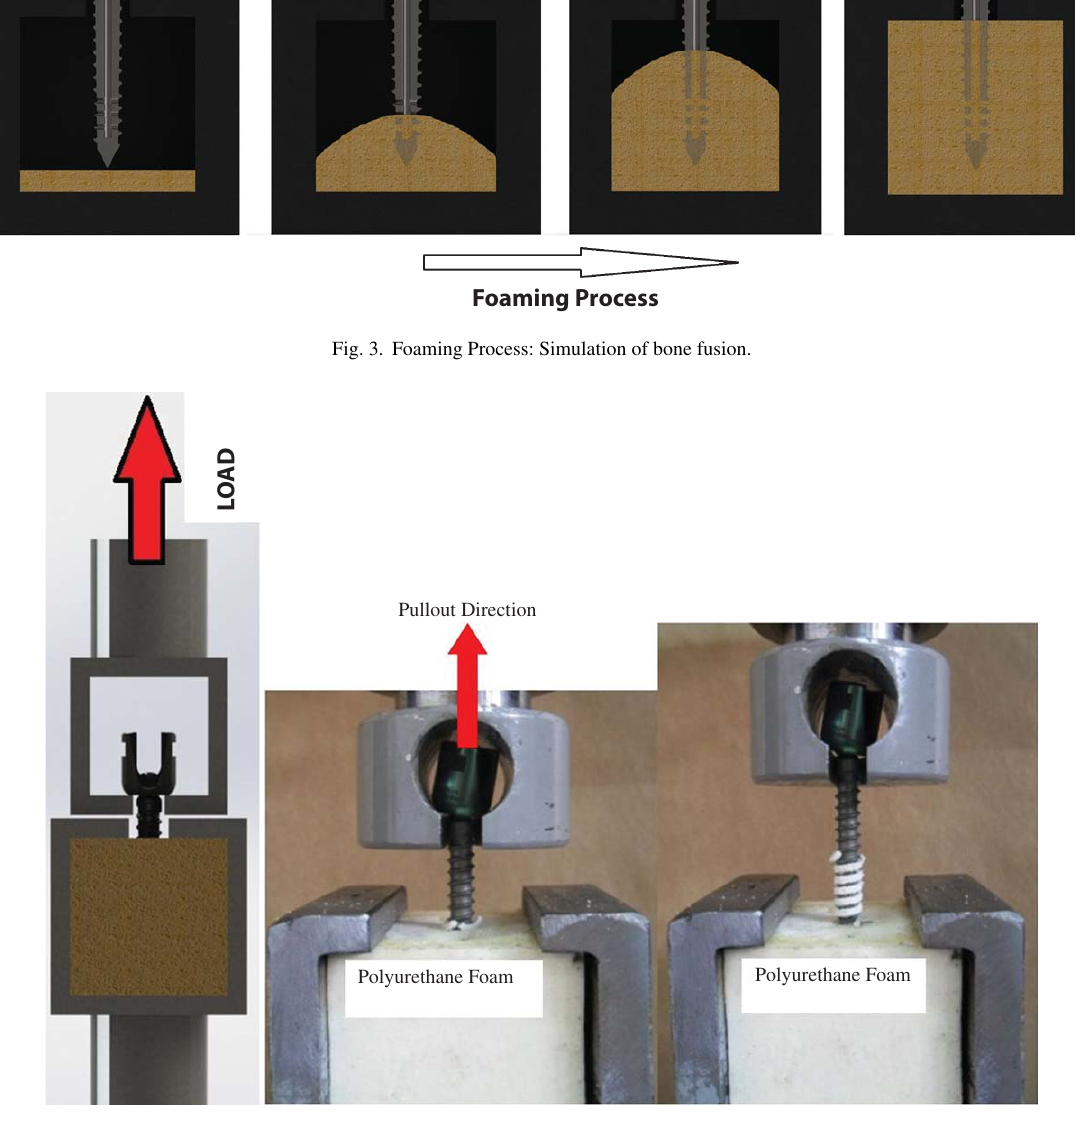
Fig. 4. Pullout test setup. From left to right; Schematic view, before pullout and after pullout,